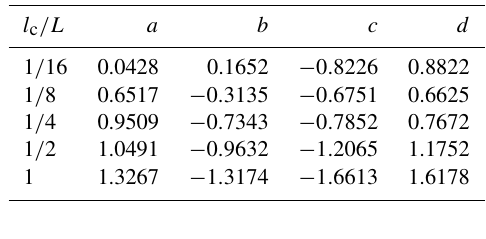
Table 3. Coefficients a , b , c , and d of Eq. (17), determined by least- square fitting for fractures with varying l c /L ratios.